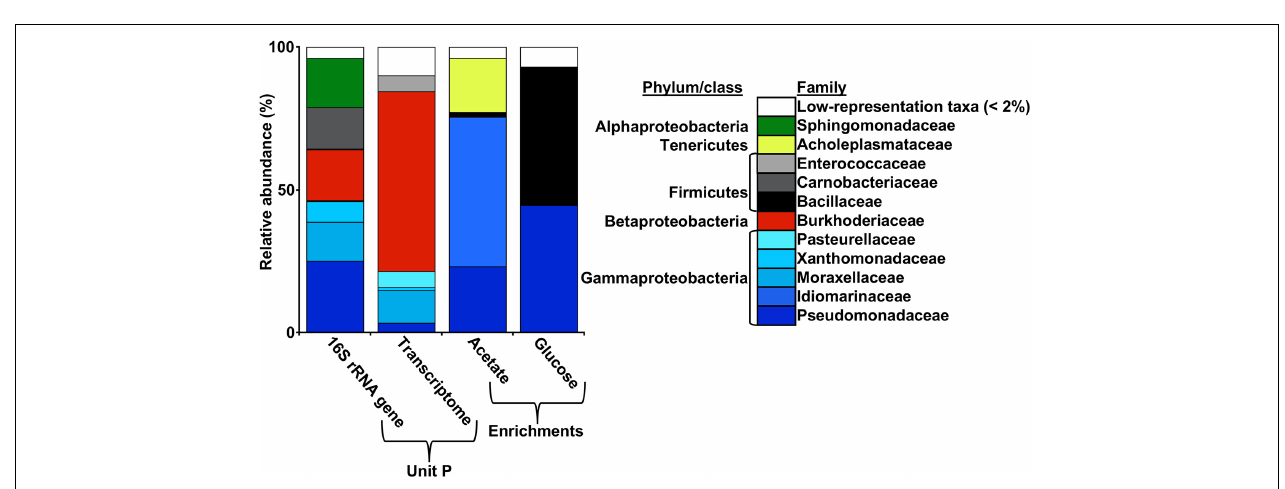
FIGURE 2 | Relative abundances of 16S rRNA gene sequencing-derived OTU at the phylum-level (class-level for Proteobacteria) in wFGD source waters and units, consensus taxonomic assignments of 16S rRNA in the Unit P transcriptome (A) , and functional assignments of transcripts detected in Unit P (B) .